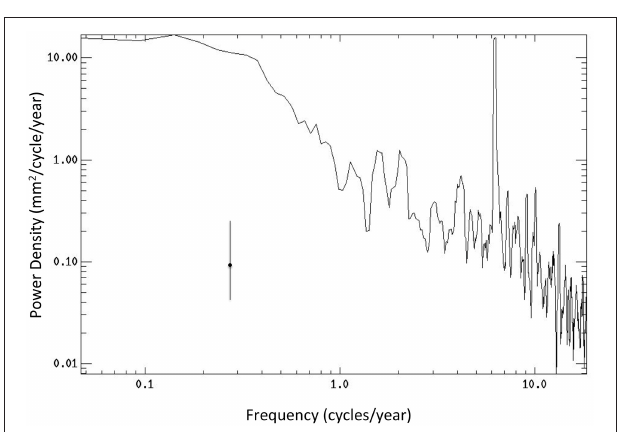
FIGURE 3 | The frequency spectrum of the time series shown in Figure 1 with a linear trend removed. The error bar represents the 95% confidence